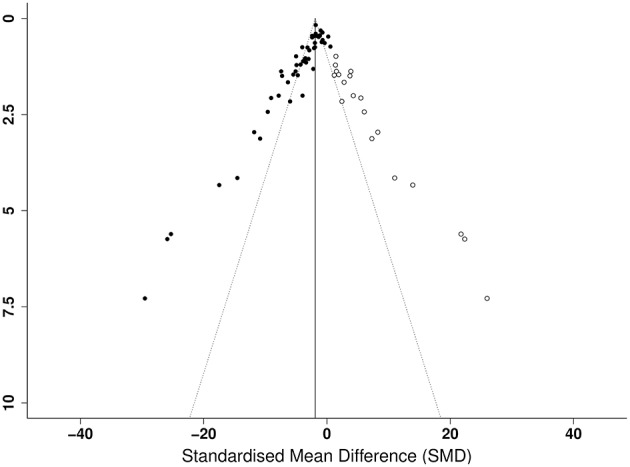
Trim and fill analysis of lesion volume showing published studies (filled circles) and estimated unpublished studies (unfilled circles). The solid vertical line indicates the adjusted effect size.